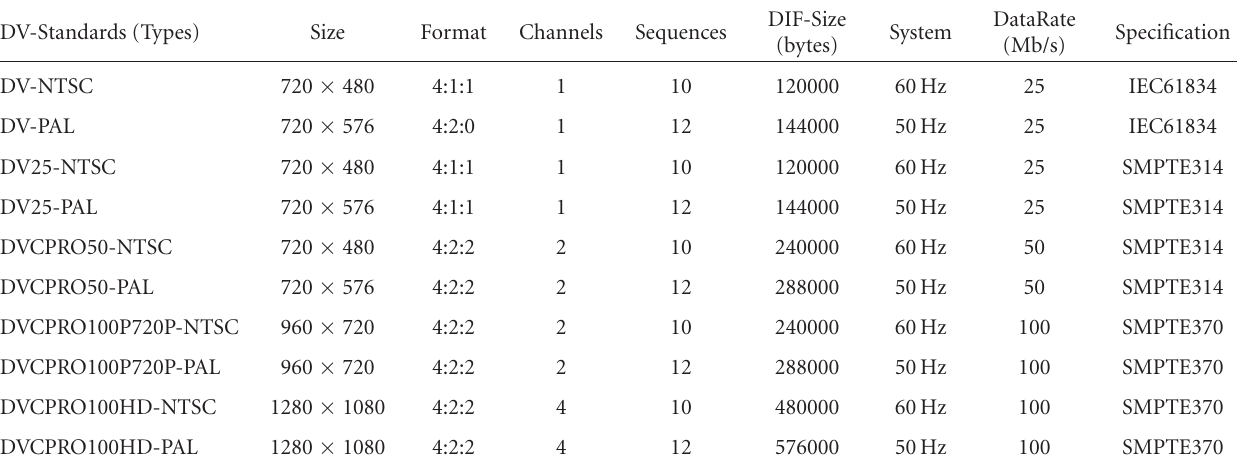
Table 1: Formats of DV standards.